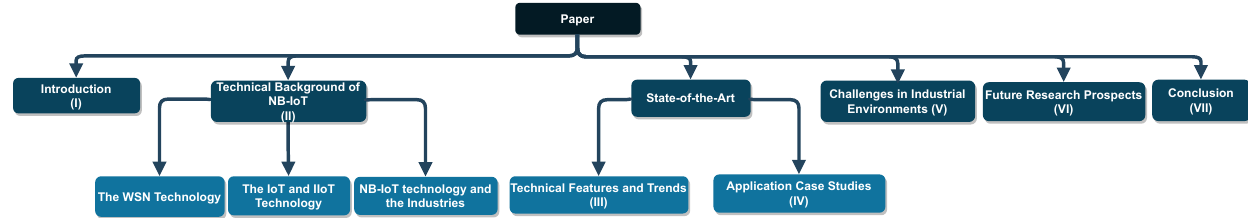
Figure 1. A structural description of the paper